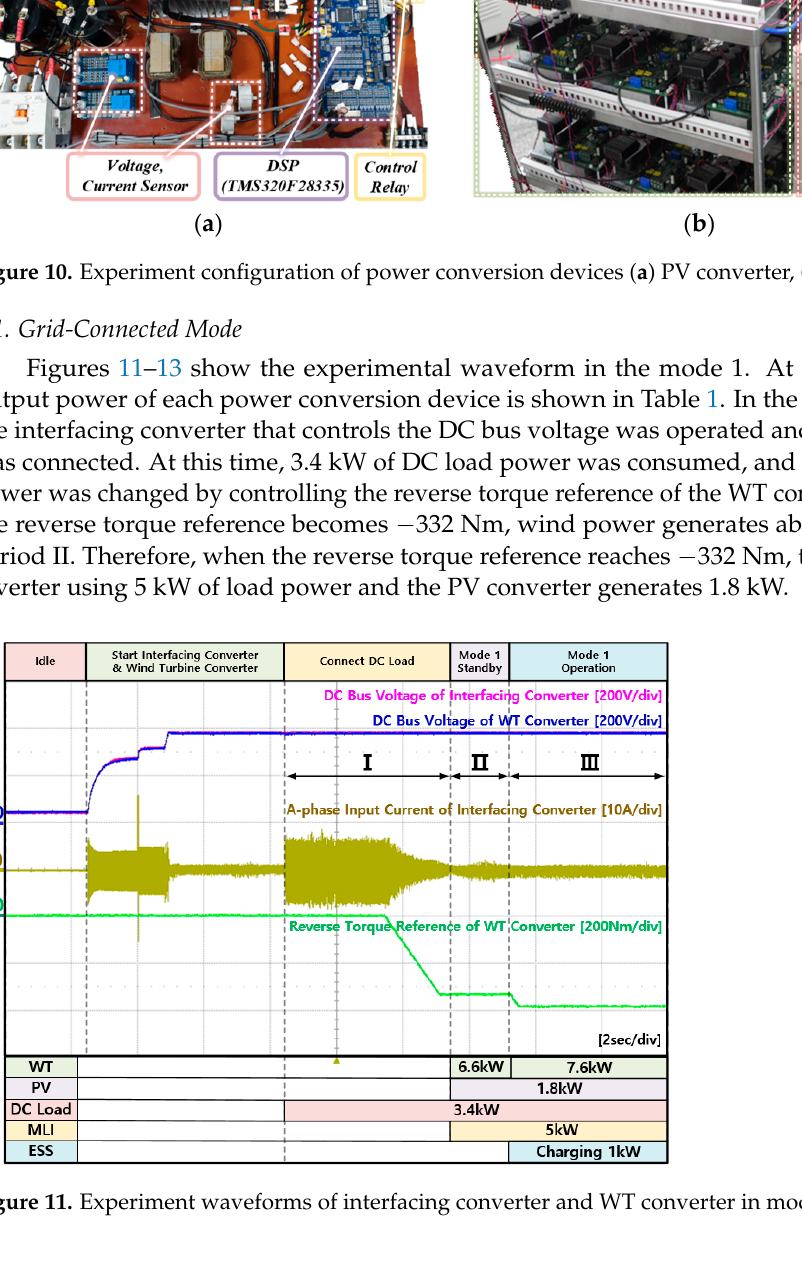
Figure 10. Experiment configuration of power conversion devices ( a ) PV converter, ( b ) MLI.